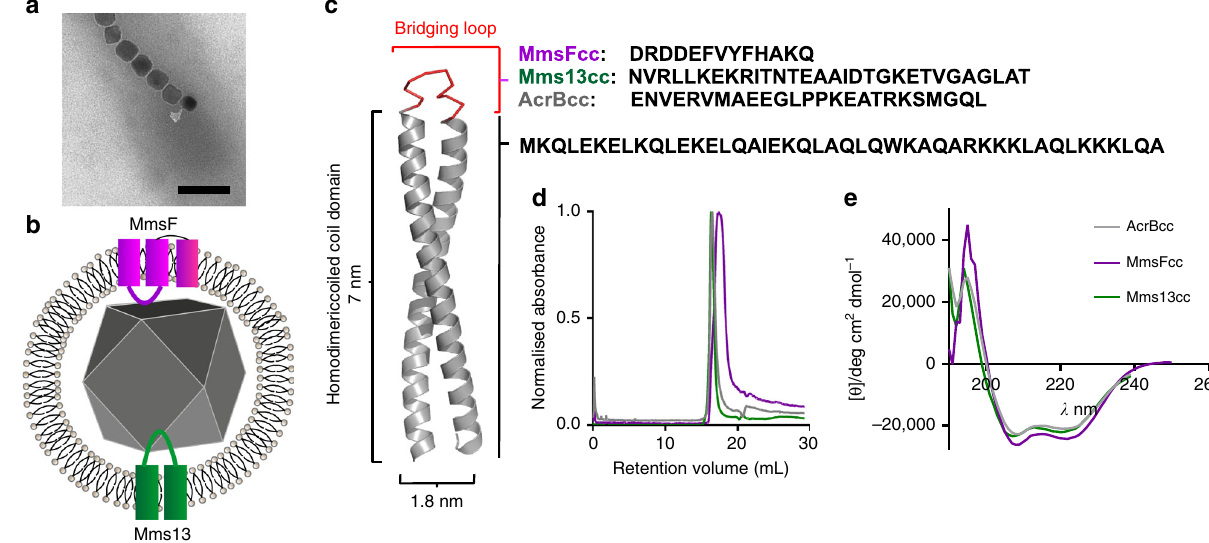
Fig. 1 Design and characterisation of the coiled coil proteins. a TEM image of magnetosomes inside an M. magneticum AMB-1 cell (scale bar is 100 nm) and b a schematic of the magnetosome membrane and magnetite crystal showing the topology of Mms13 (green) and MmsF (purple) in the membrane with the transmembrane region shown as cylinders. c Robetta model 60 of the coiled coil construct generated in PyMOL 68 , grey is the homodimeric coiled coil and red is the variable bridging loop comprising sequences from MmsF, Mms13, and AcrB; d size exclusion chromatography and e circular dichroism spectra of MmsFcc, Mms13cc, and